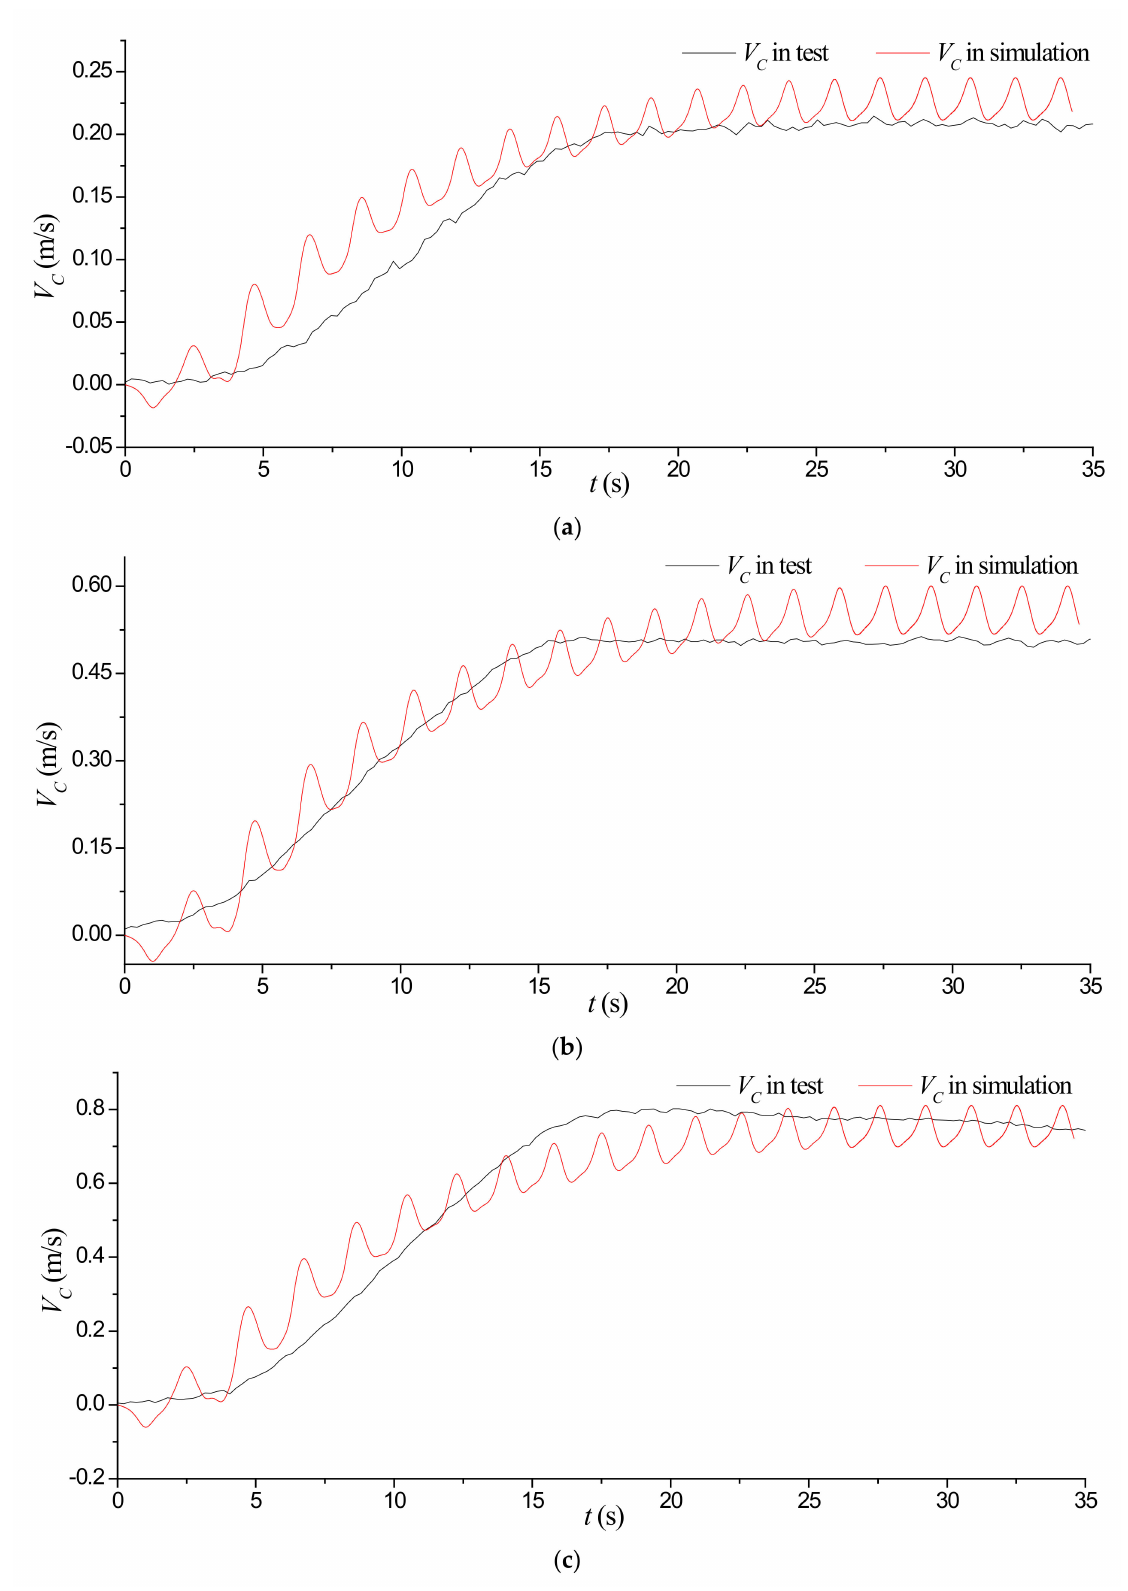
Figure 15. Comparison between V C in test and that in simulation when the wavelength is 8 m. ( a ) Comparison of V C under wave height of 0.15 m when the wavelength is 8 m. ( b ) Comparison of V C under wave height of 0.2 m when the wavelength is 8 m. ( c ) Comparison of V C under wave height of 0.25 m when the wavelength is 8